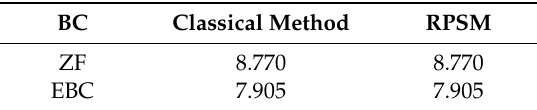
Table 11. The spherical reactor critical radius a c .